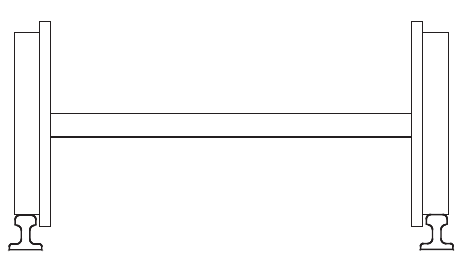
Figure 4: Wheelset-wheel-rail